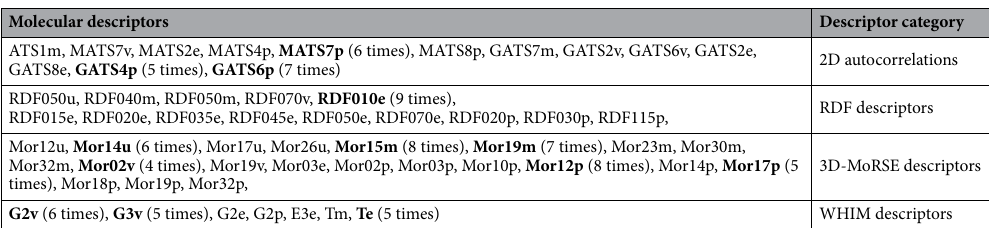
Table 8. The total 56 descriptors selected by GA carried out to out-of-sample testing validation. The most frequent descriptors, also included in model 1 (Eq. 4), are in